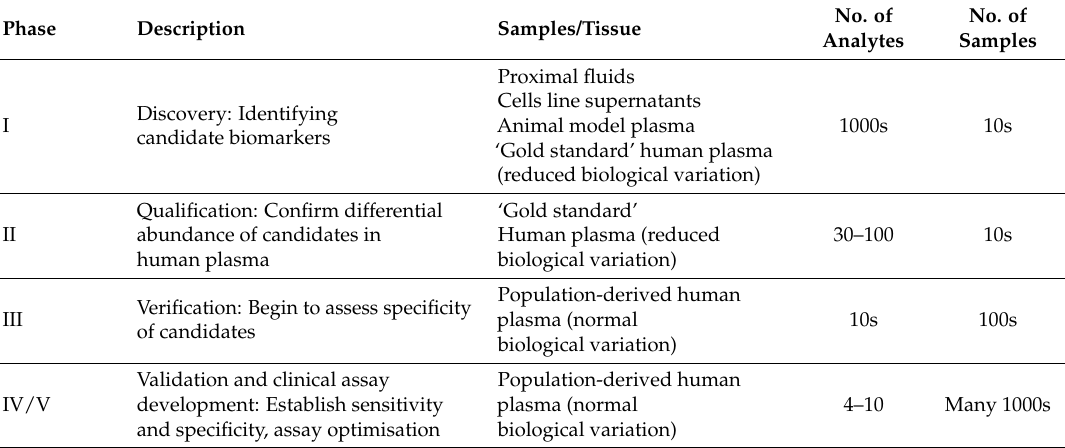
Table 1. Phases of biomarker research with burden of tissue and samples (Adapted from Rifai et al. [14]).